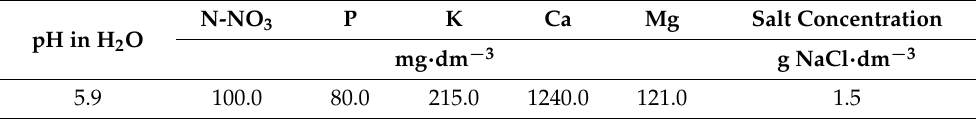
Table 1. Substrate for seedling production.